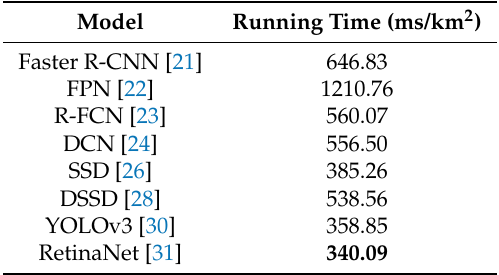
Table 7. Comparison of running time. The bold font indicates the best